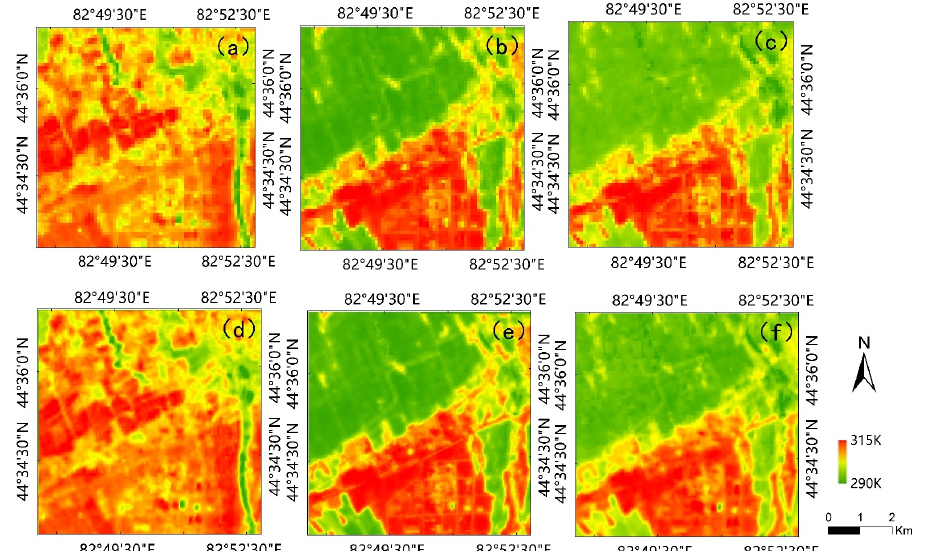
Figure 5. Underlying surface types of region A ( a ) 9 April 2019, ( b ) 24 July 2019, ( c ) 26 August 2019.